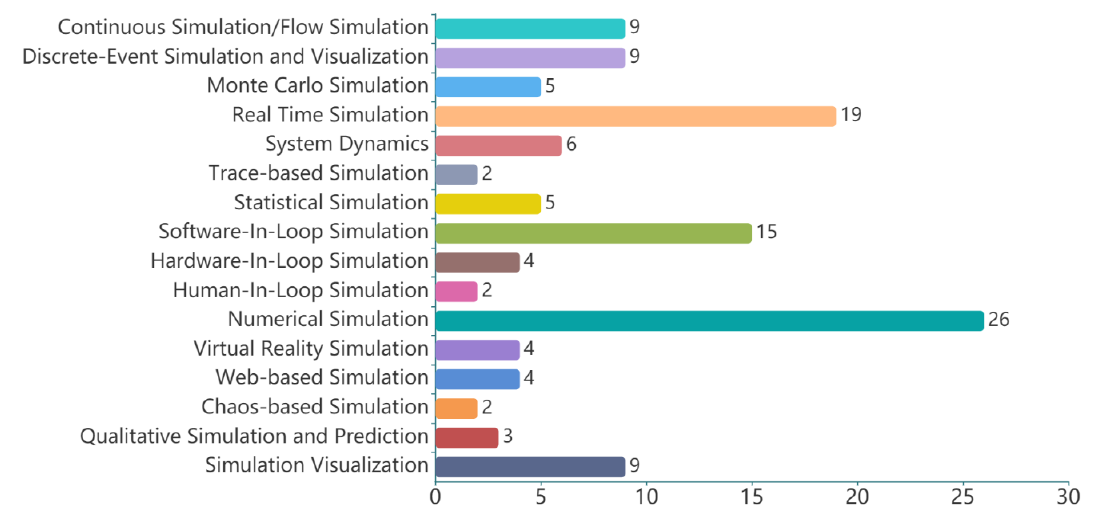
Figure 11. Simulation methods used in the